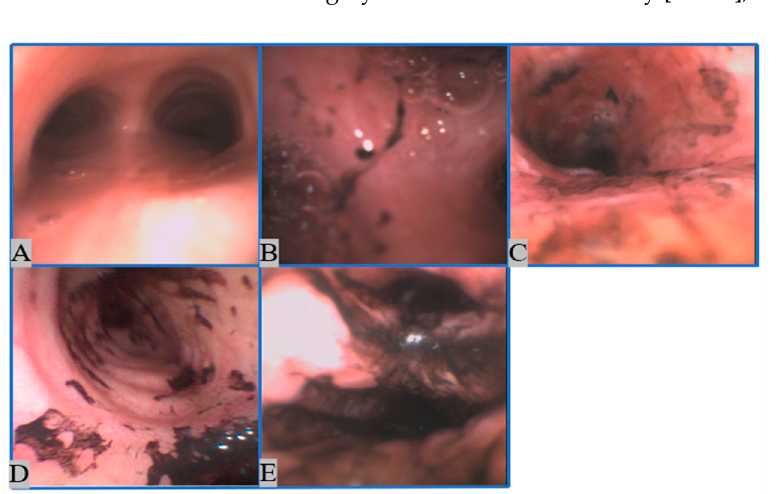
Figure 1. An example of grading of inhalation injury using the abbreviated injury score (AIS). ( A )—no injury; ( B )—mild injury; ( C )—moderate injury; ( D )—severe injury; ( E )—massive injury.